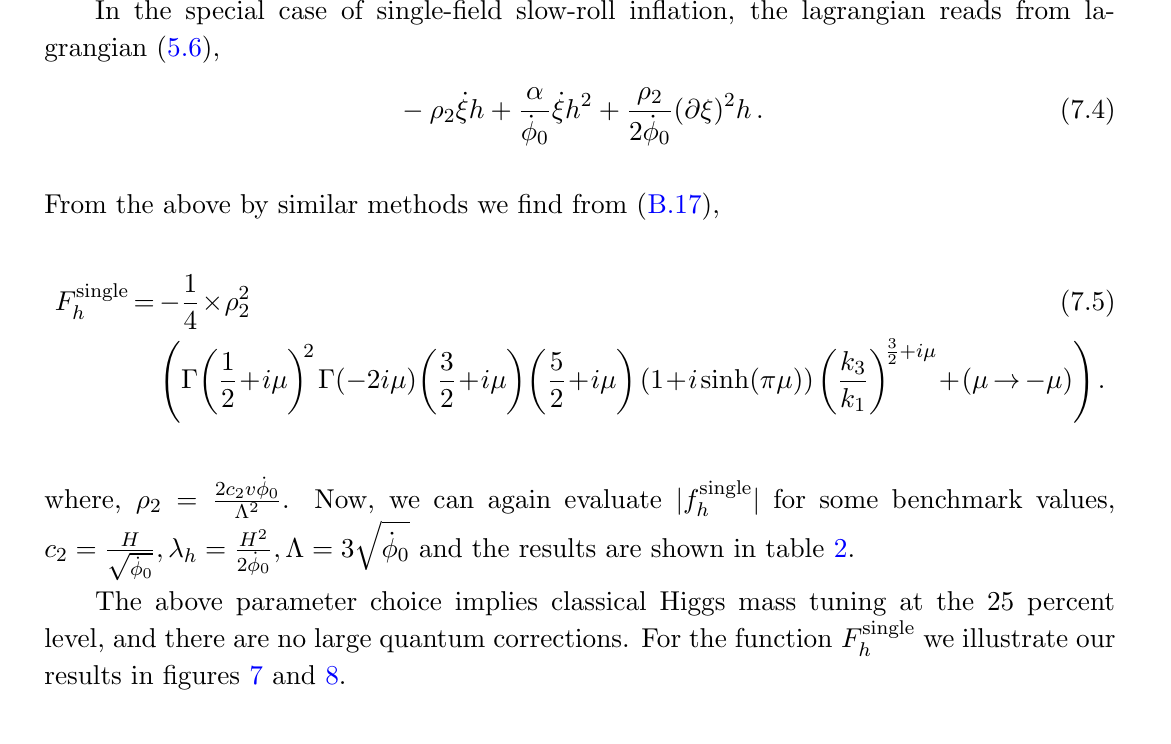
In the special case of single-(cid:12)eld slow-roll in(cid:13)ation, the lagrangian reads from la- grangian